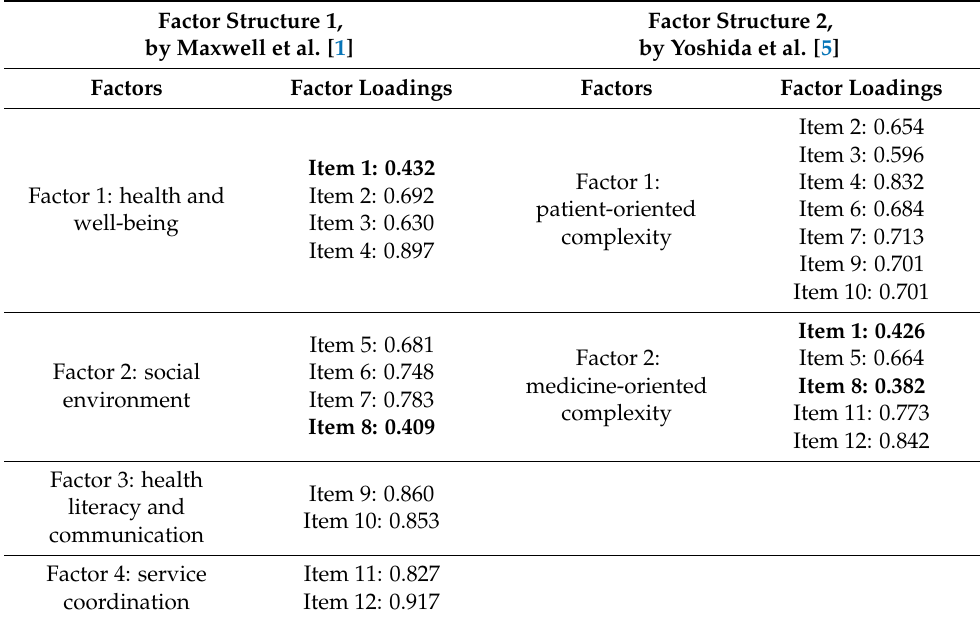
Table 2. Factor loadings of items within the two assessed factor structures.